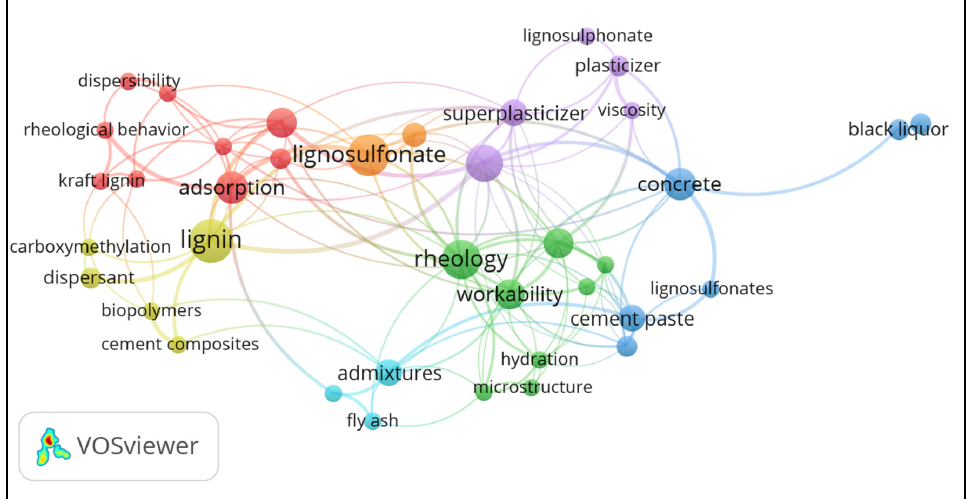
Figure 5. Co-occurrence network of keywords.